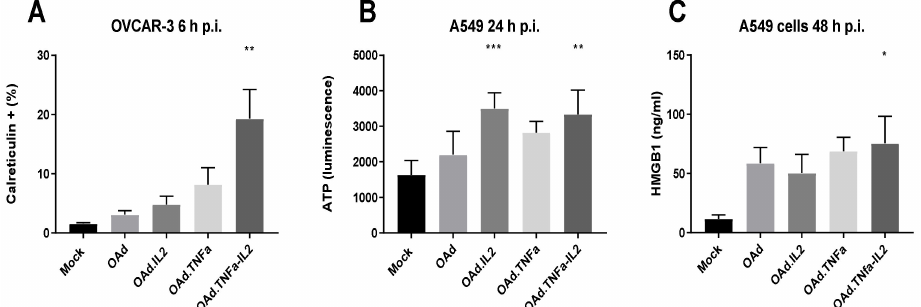
Figure 1. OAd.TNFa-IL2 induces alarmin release associated with danger- and pathogen-associated molecular pattern (DAMP and PAMP, respectively) signaling. Di ff erent cell lines were infected with an unarmed oncolytic adenovirus (OAd), Ad5 / 3-E2F-d24-hIL2 (OAd.IL2), Ad5 / 3-E2F-d24-hTNFa (OAd.TNFa), or Ad5 / 3-E2F-d24-hTNFa-IRES-hIL2 (OAd.TNFa-IL2) 100 VP / cell. The release of DAMP and PAMP molecules ( A ) calreticulin was measured by flow cytometry, and ( B ) ATP and ( C ) HMGB1 were measured by ELISA. The data are presented as mean + SEM; the group size was n > 4. Statistical significance was determined by Kruskal–Wallis test; groups were compared to mock. * p < 0.05; ** p < 0.01; *** p <